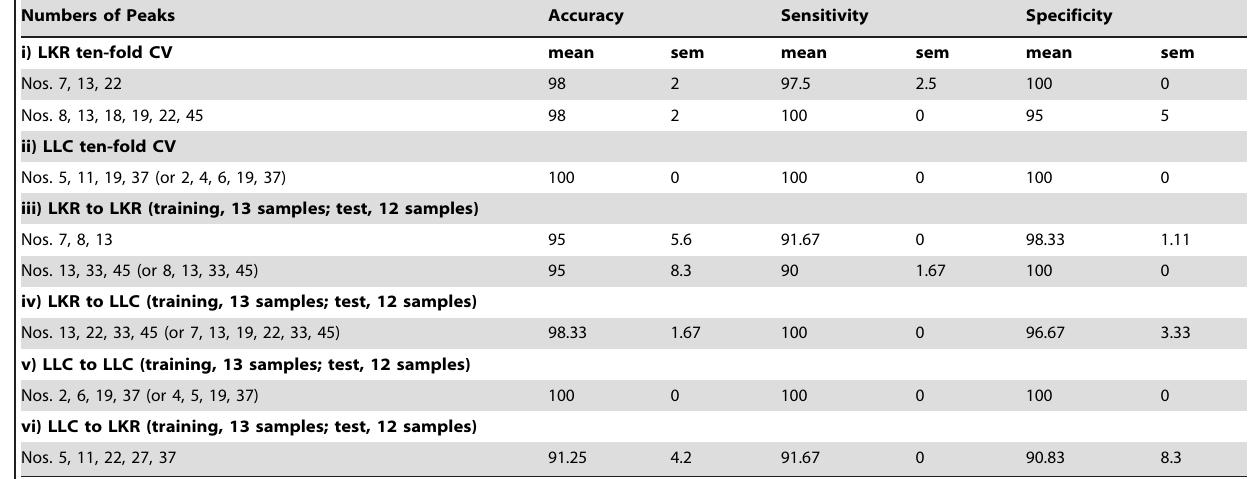
Summary of highest scores of SVM